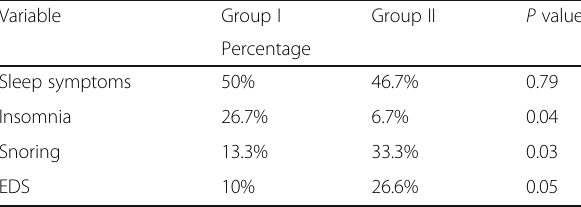
Table 5 Comparison between both groups regarding sleep related clinical